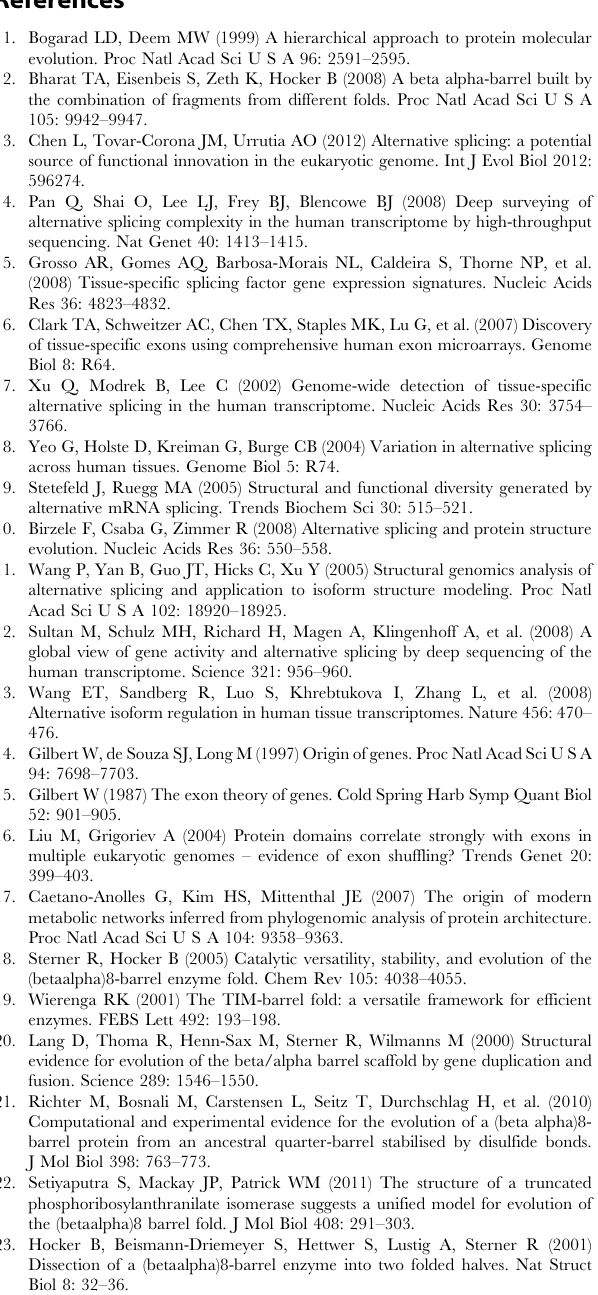
Table S7 Sequences found without selective pressure for b -strand library. Table S8 Sequences found under selective pressure for b -strand library. Table S9 Sequences found without selective pressure for a -helix library. Table S10 Sequences found under selective pressure for a -helix